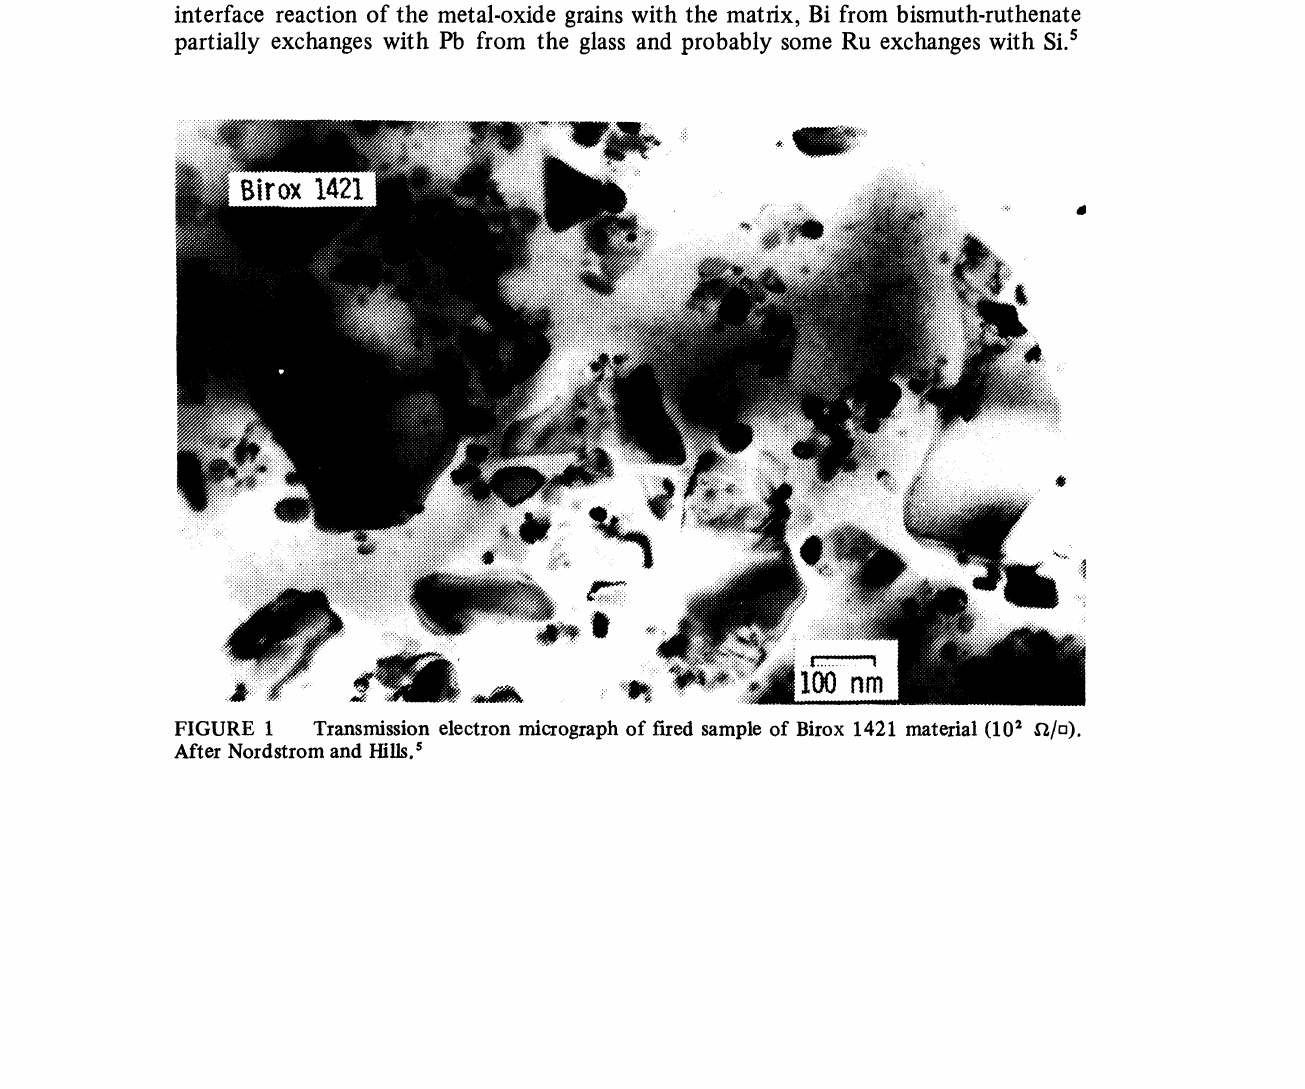
FIGURE 1 Transmission electron micrograph of fired sample of Birox 1421 material (10 After Nordstrom and